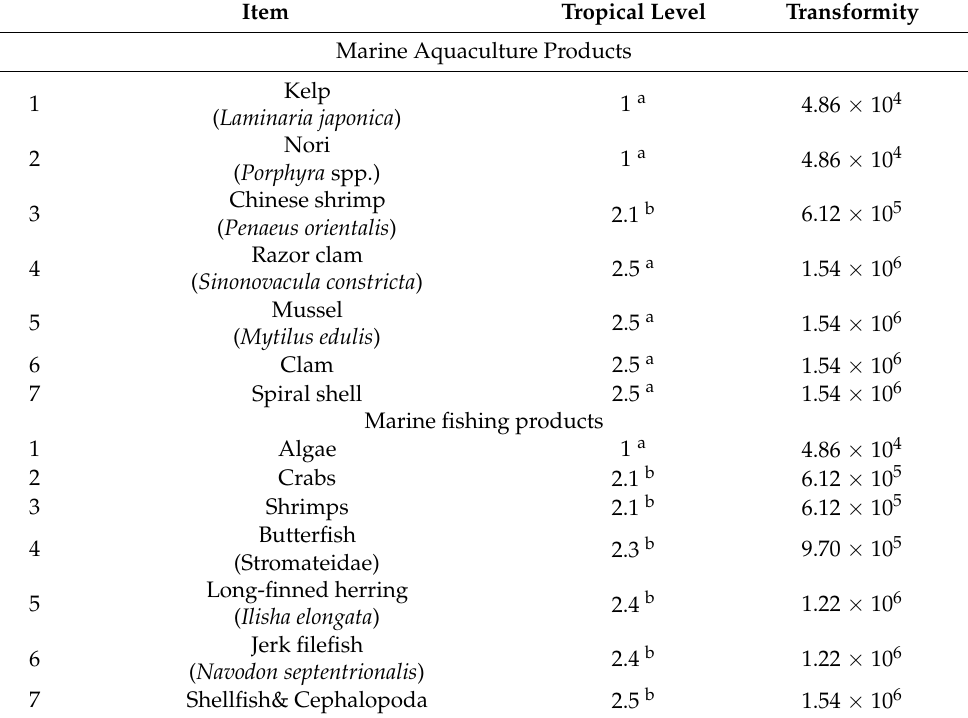
Table 1. Transformities of the products of marine aquaculture and marine fishing. Item Tropical